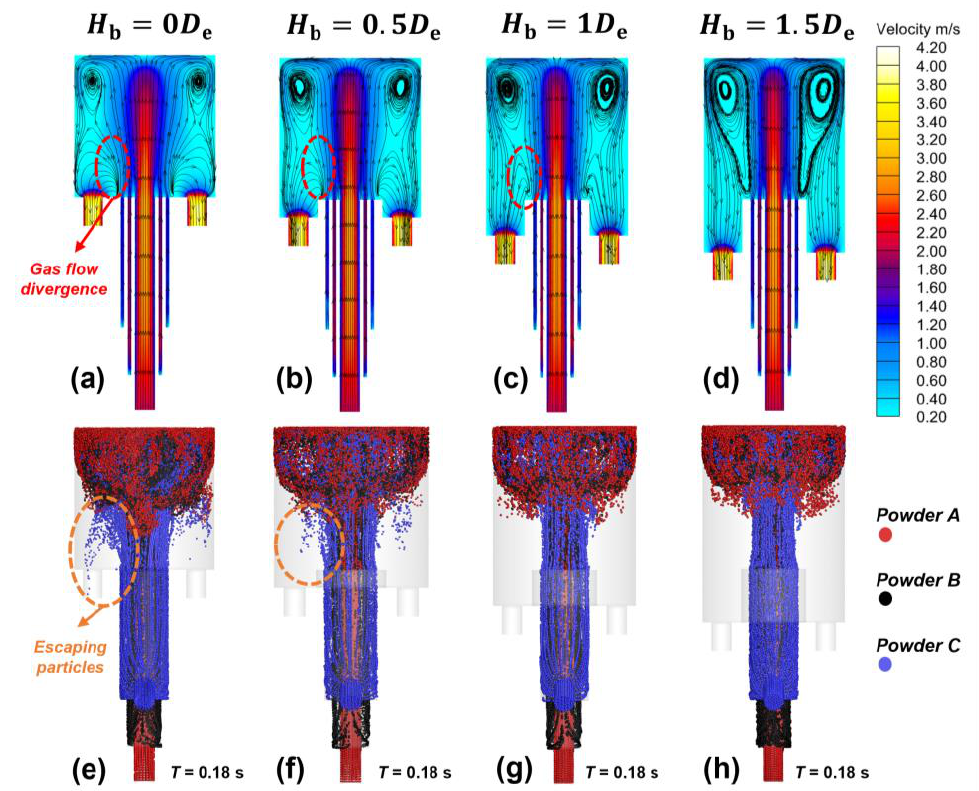
Figure 7. ( a – d ) Velocity contour and streamline; ( e – h ) Particle distribution diagrams of mixers with Figure 7. (a–d) Velocity contour and streamline; (e–h) Particle distribution diagrams of mixers with different bottom different bottom heights.